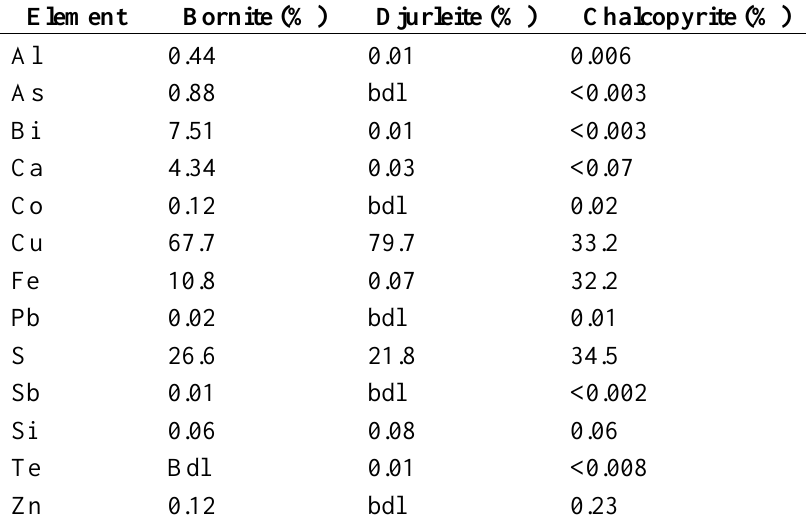
Table 1. Elemental compositions of copper sulphide minerals.